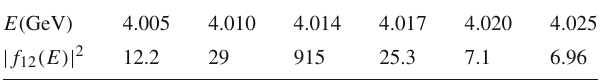
Table 5 The values of the | f 12 ( E ) | 2 near the channel thresholds for the transition 5)